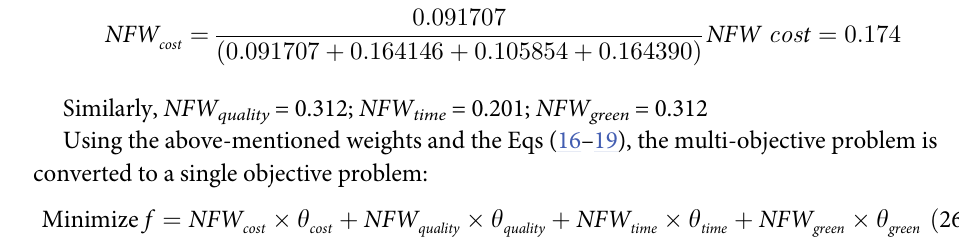
Similarly, the aggregate fuzzy number of the other three objective functions are calculated. The normalized fuzzy weights of all objective functions are determined by Eq 20. The normal- ized fuzzy weight for the cost is calculated as mentioned below: ¼ NFW cost Similarly, NFW = 0.312; NFW = 0.201; NFW = 0.312 quality time green Using the above-mentioned weights and the Eqs (16–19), the multi-objective problem is converted to a single objective problem: